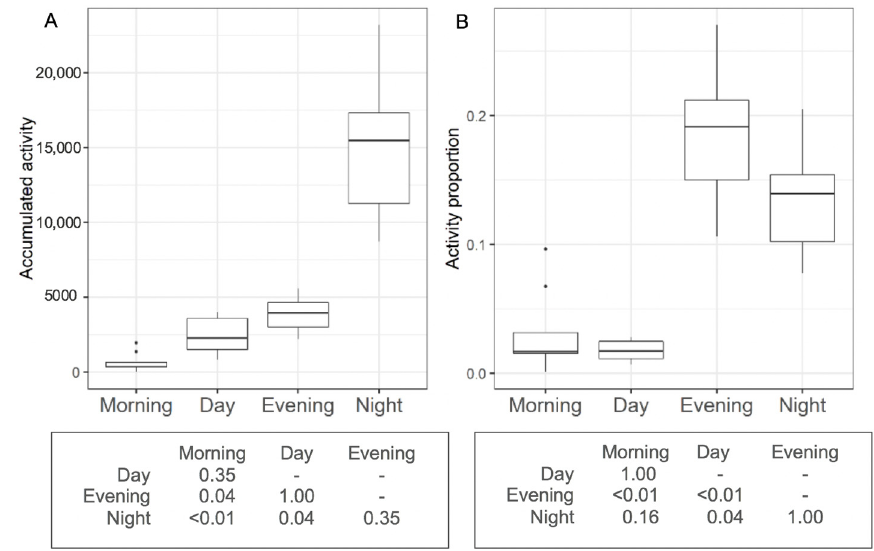
Figure 5. ( A ) Accumulated durations of high-activity events averaged over the individual catfish during the main study period (March–August). ( B ) The accumulated duration of high-activity events averaged over each individual and weighted against available time in the respective time period during the main study period (March–August). Tables of Bonferroni-corrected p -values from Conover’s all-pairs comparisons posthoc tests of Friedman-type ranked data are found below the respective table.